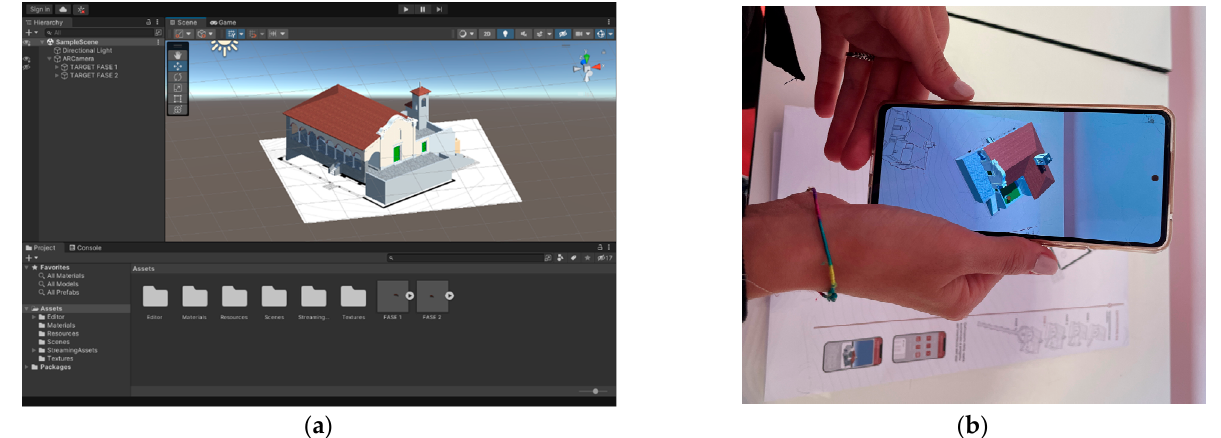
Figure 14. ( a ) Organization of the scene containing target image and model inside Unity Reflect software; ( b ) AR visualisation of one of the phases of the model, defined from its target.